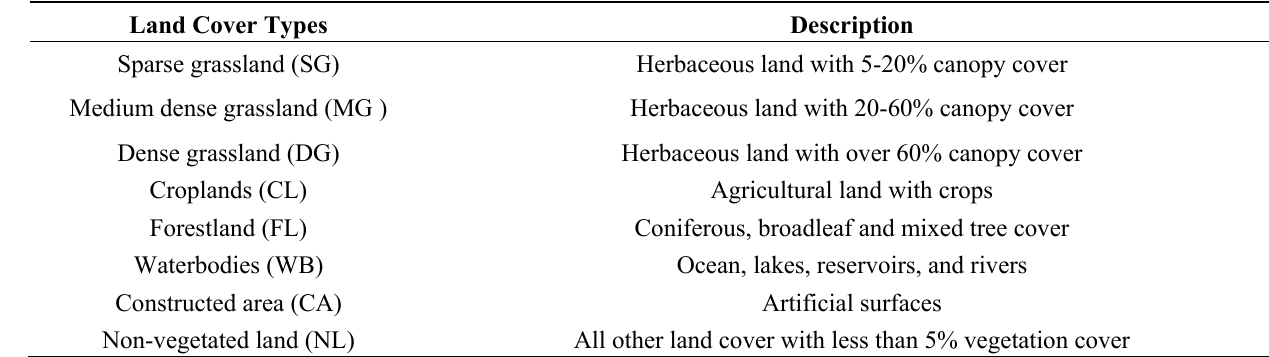
Table 1. Reclassified Chinese Academy of Sciences (CAS) land cover